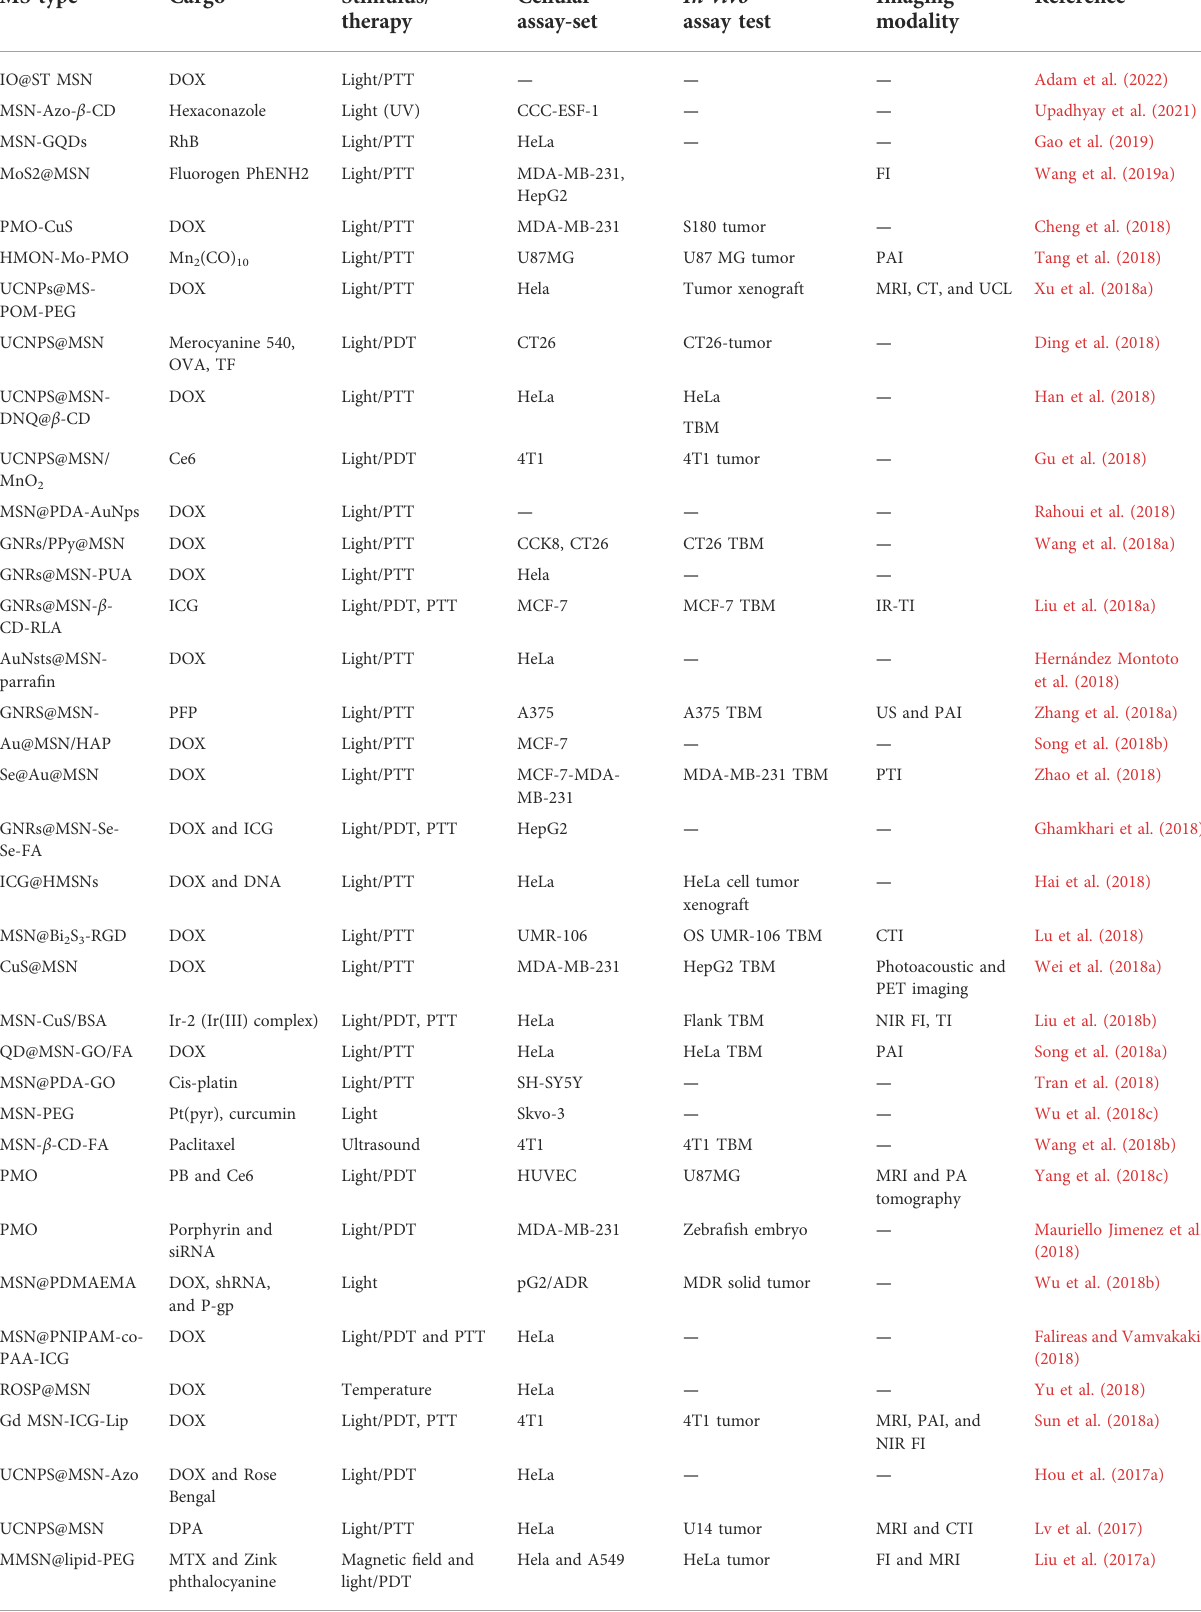
TABLE 3 Physically triggered MSN concerning the type of stimulus and cargo for in vitro and in vivo investigation, therapy, and